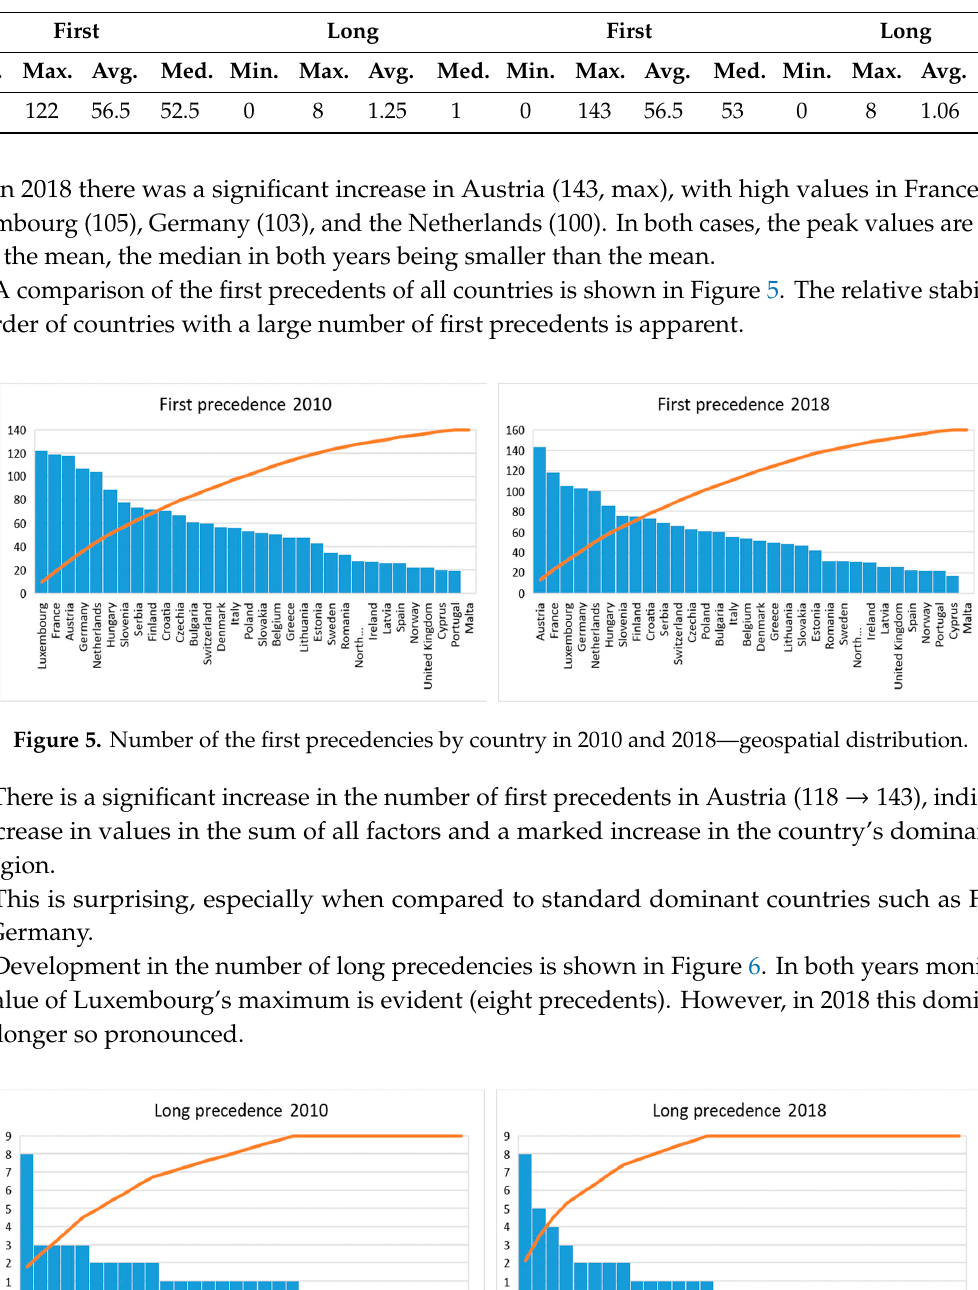
Figure 6. Number of the long precedencies by country in 2010 and 2018—geospatial distribution.